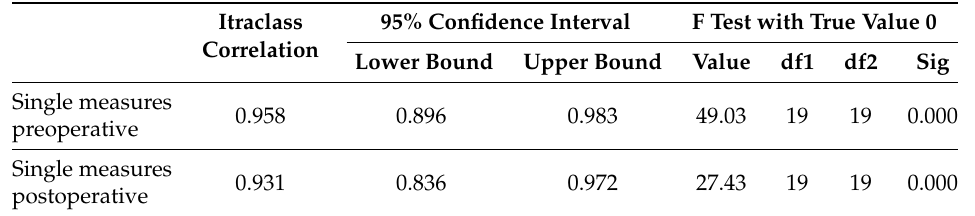
Table 1. Results of Intraclass Correlation Coefficient (ICC) using single rater, absolute agreement and 2-way random effects model.